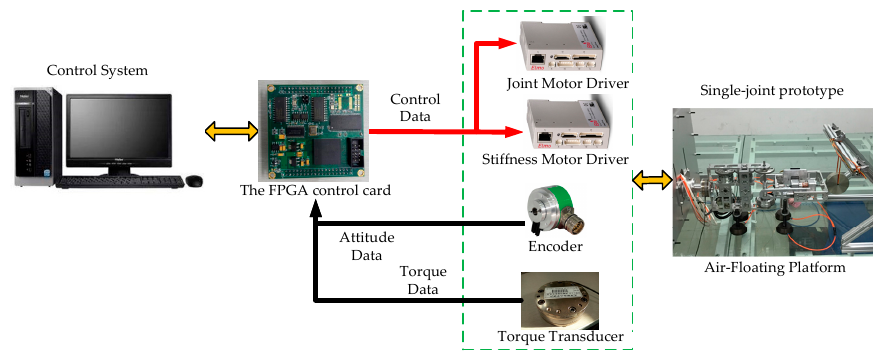
Figure 8. The diagram of the experimental system.